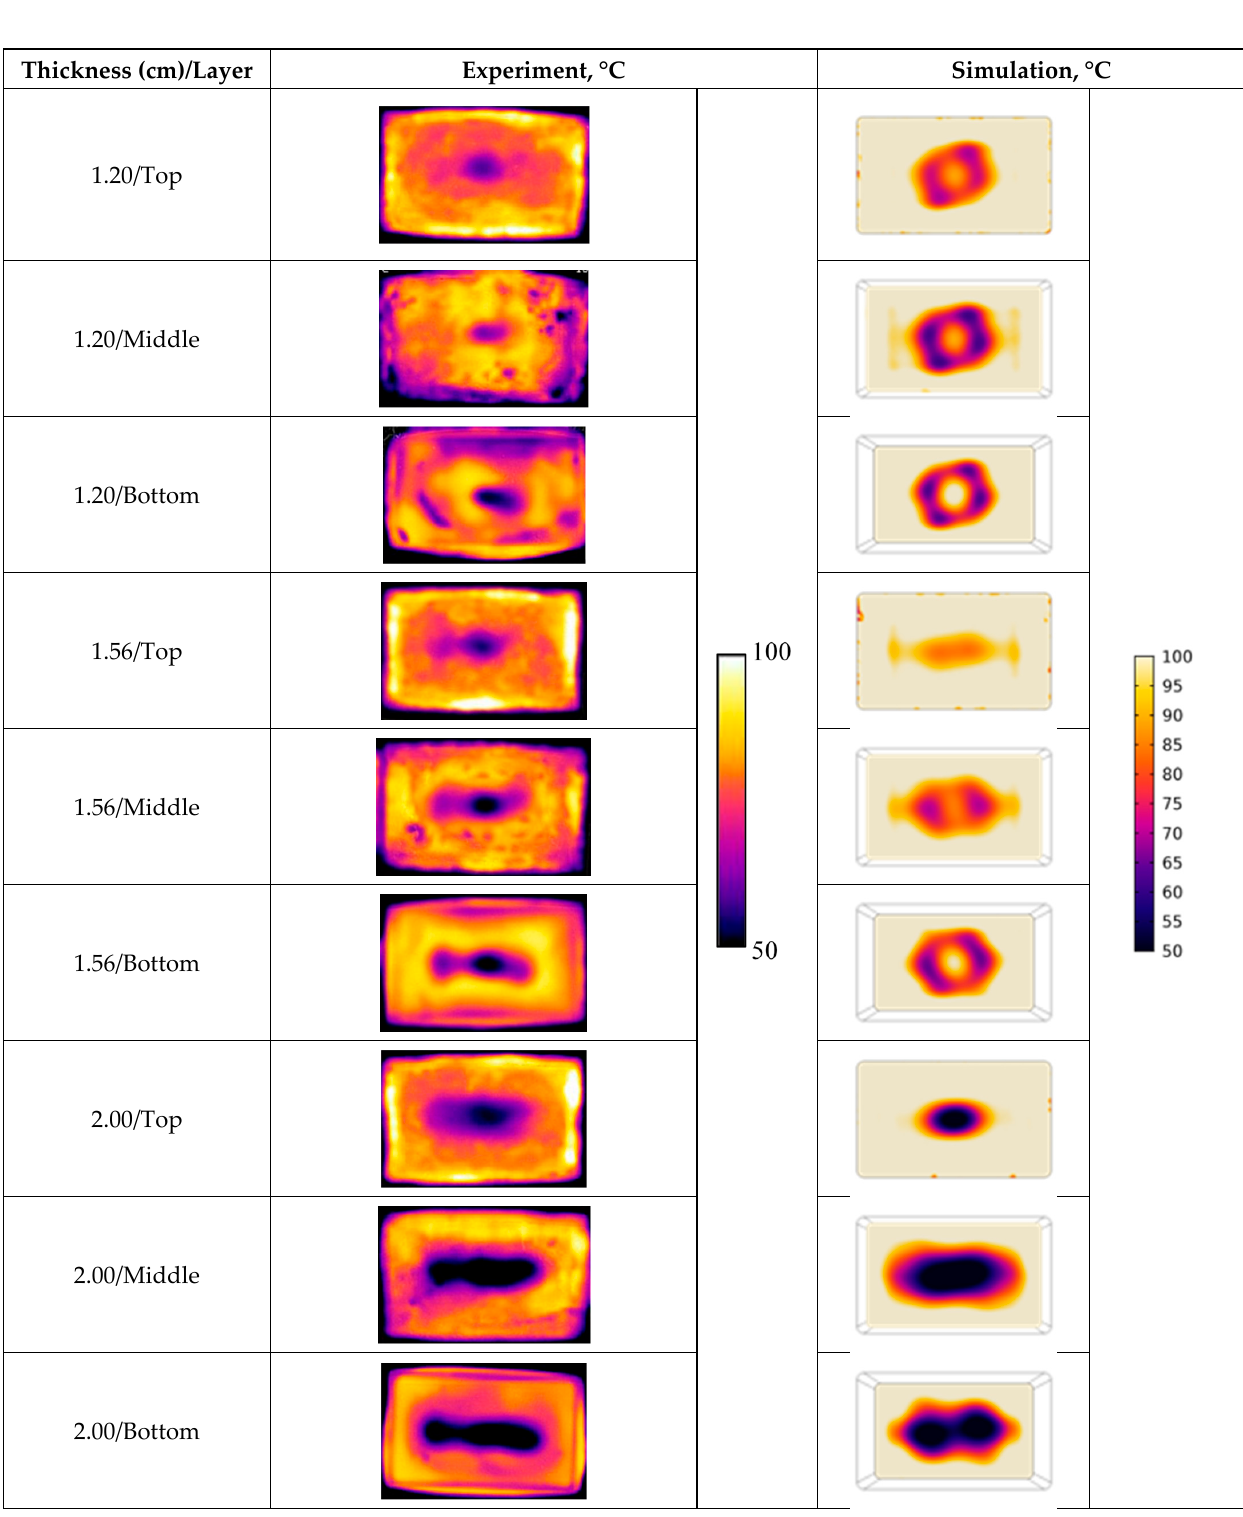
Figure 11. Comparison between experimental and simulated temperature profiles after six-minute heating.